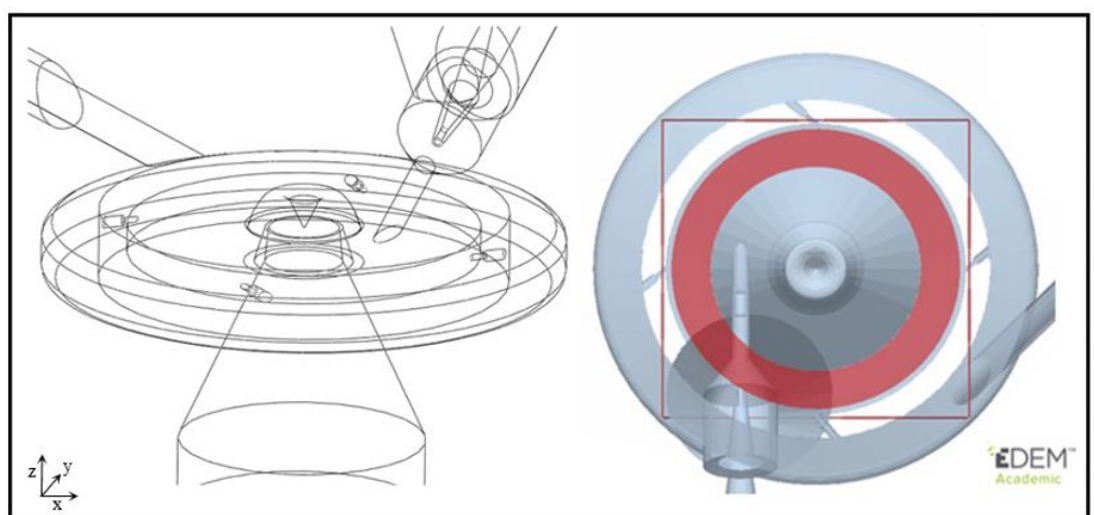
Fig 1: In-house drawing of the Hosokawa Micron AS-50 (left). Simulation domain in EDEM TM with simulation factory highlighted in red (right)